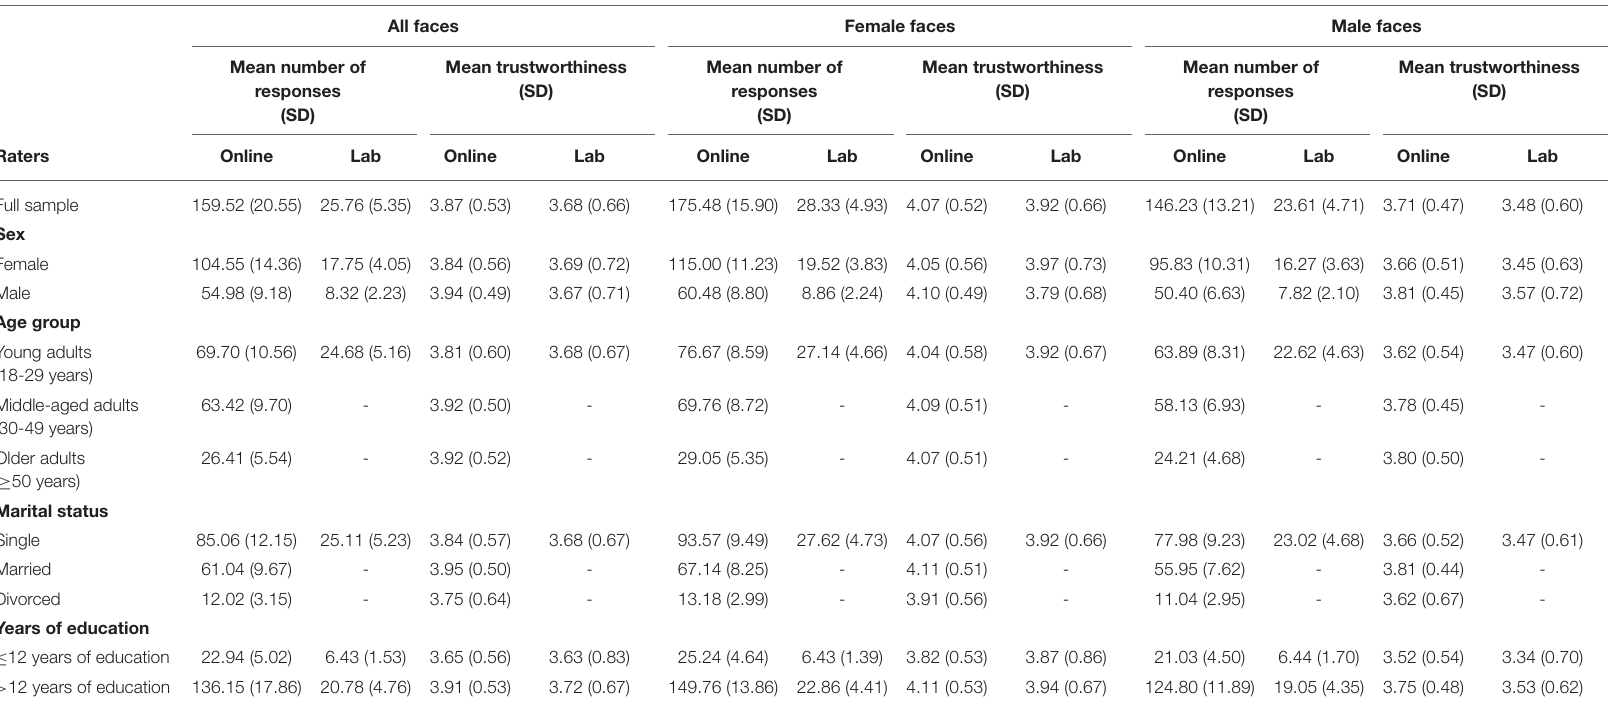
TABLE 2 | Mean number of responses and mean trustworthiness ratings, and corresponding standard deviations (SD), for all faces and separately for the female and male